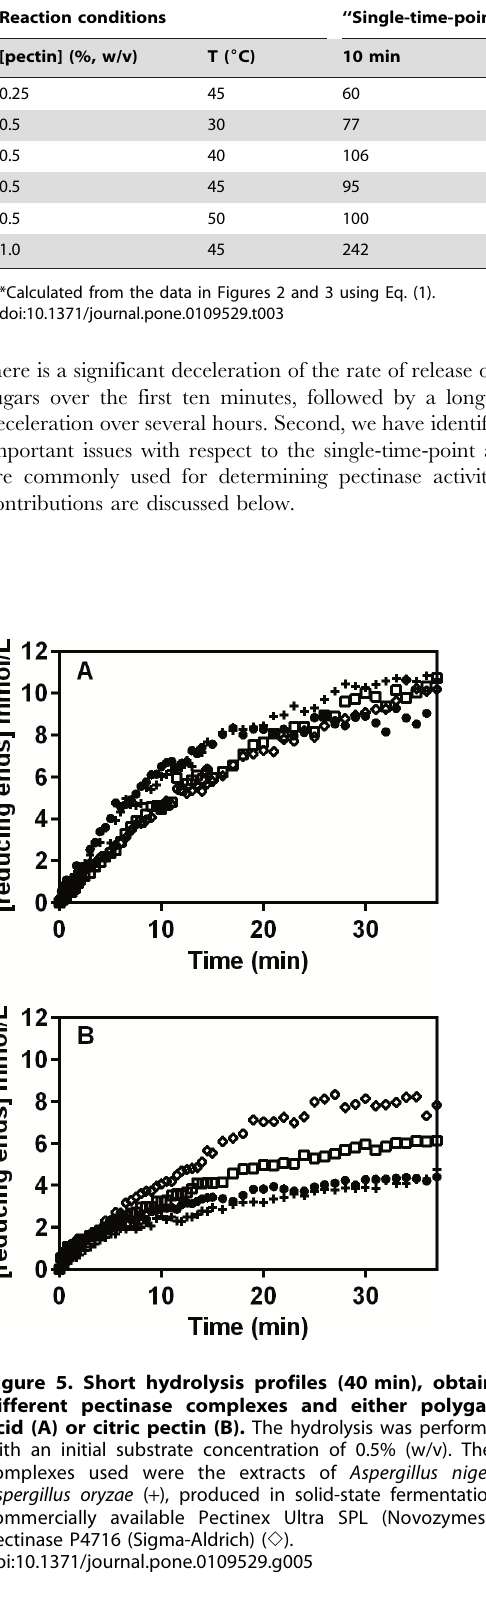
Reaction conditions